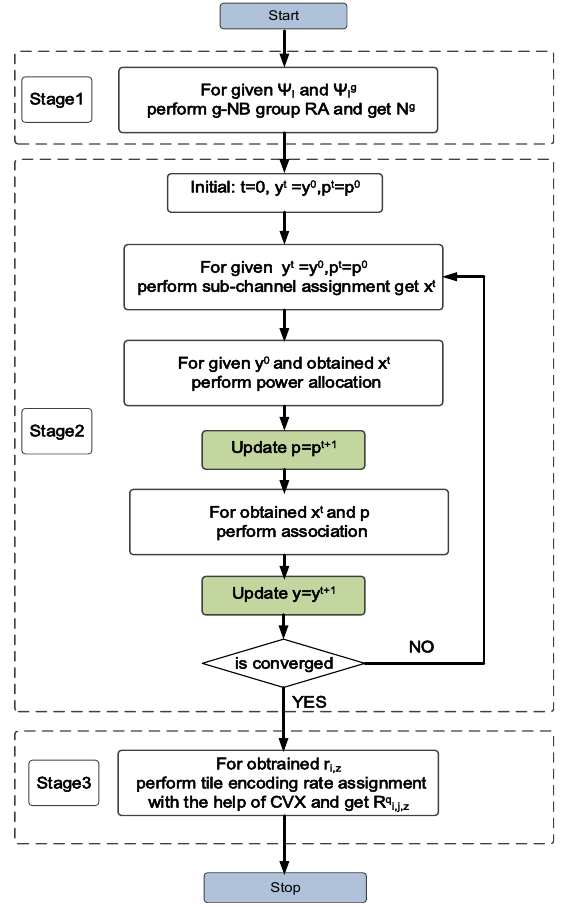
Figure 5. Flow chat of Proposed